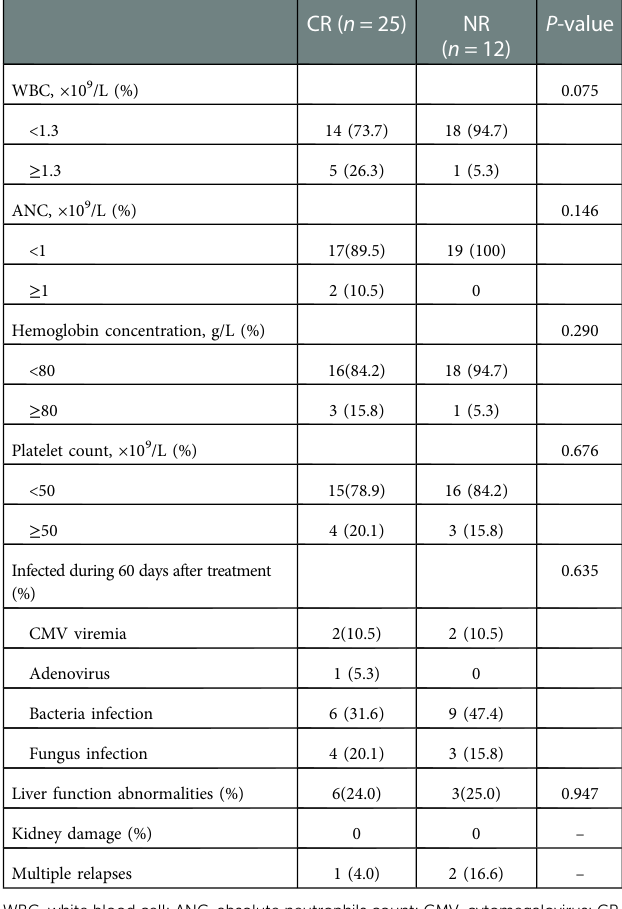
TABLE 4 Complications resulting from HDS treatment. TABLE 3 Response to treatment